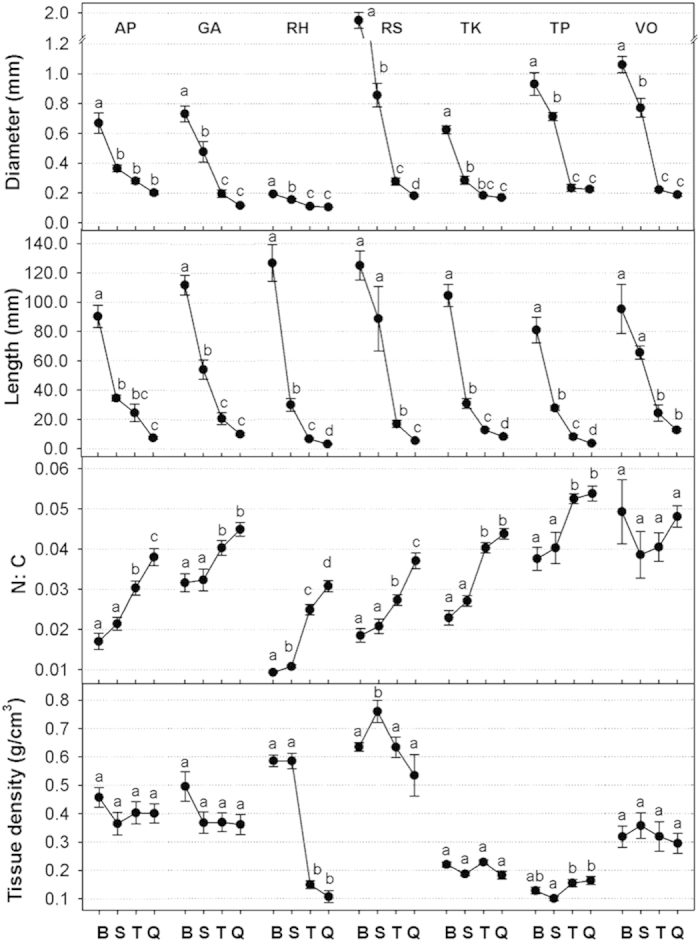
Root morphological traits for roots of different branching levels (basal root: B, secondary root: S, tertiary root: T, quaternary root: Q) from seven temperate perennial herb and grass understory species.Error bars represent one standard error of the mean. Lowercase letters within a species indicate significant (P < 0.05) differences among individual root branching levels. Abbreviations of species names are shown in Table 1.